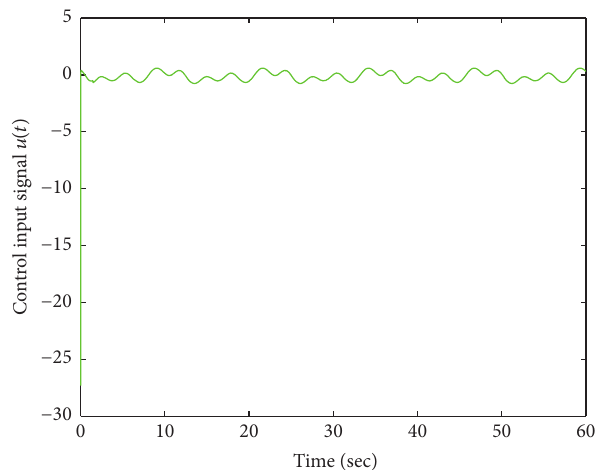
Figure 7: Respond curve of the control input 𝑢(𝑡)